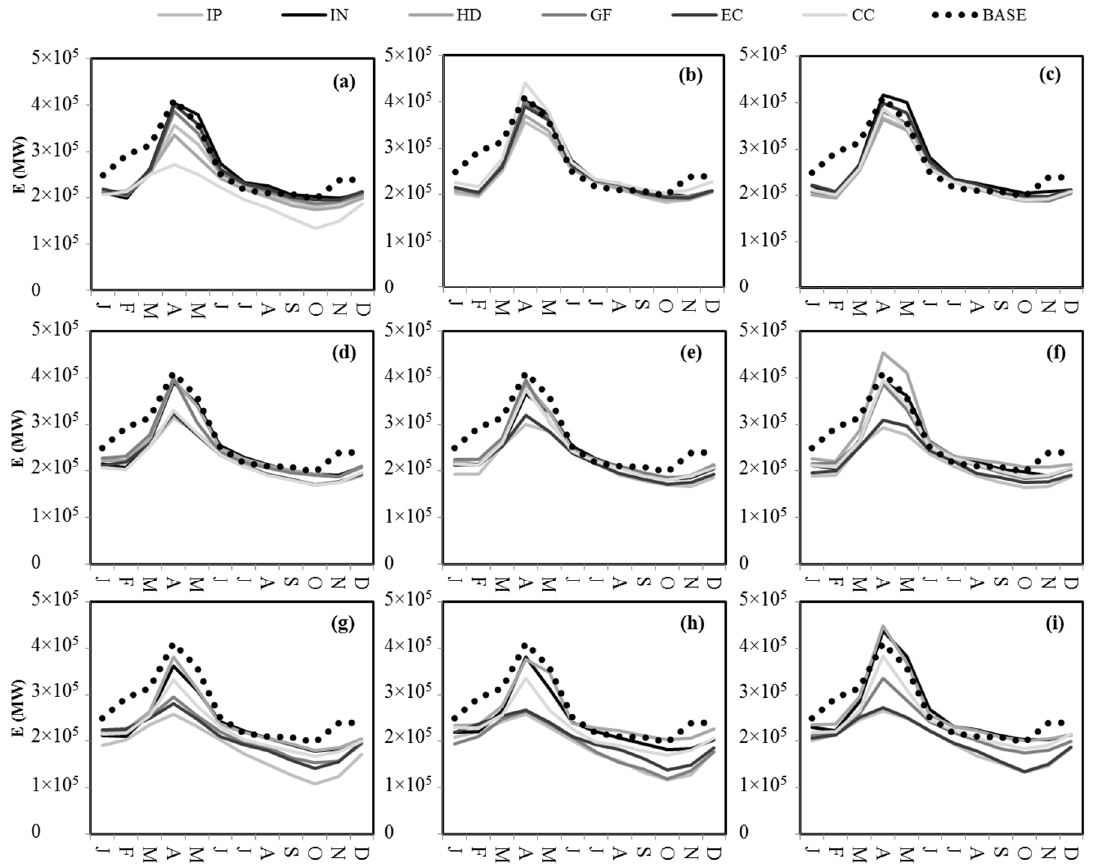
Figure 9. The monthly hydropower generation of the Bakhtiari power plant for the base period and under climate change conditions projected by the six GCMs and three SRES scenarios for the 2020s, 2050s, and 2080s time horizons; ( a ): A1B-2020s; ( b ): A2-2020s; ( c ): B1-2020s; ( d ): A1B-2050s; ( e ): A2-2050s; ( f ): B1-2050s; ( g ): A1B-2080s; ( h ): A2-2080s; ( i ): B1-2080s.